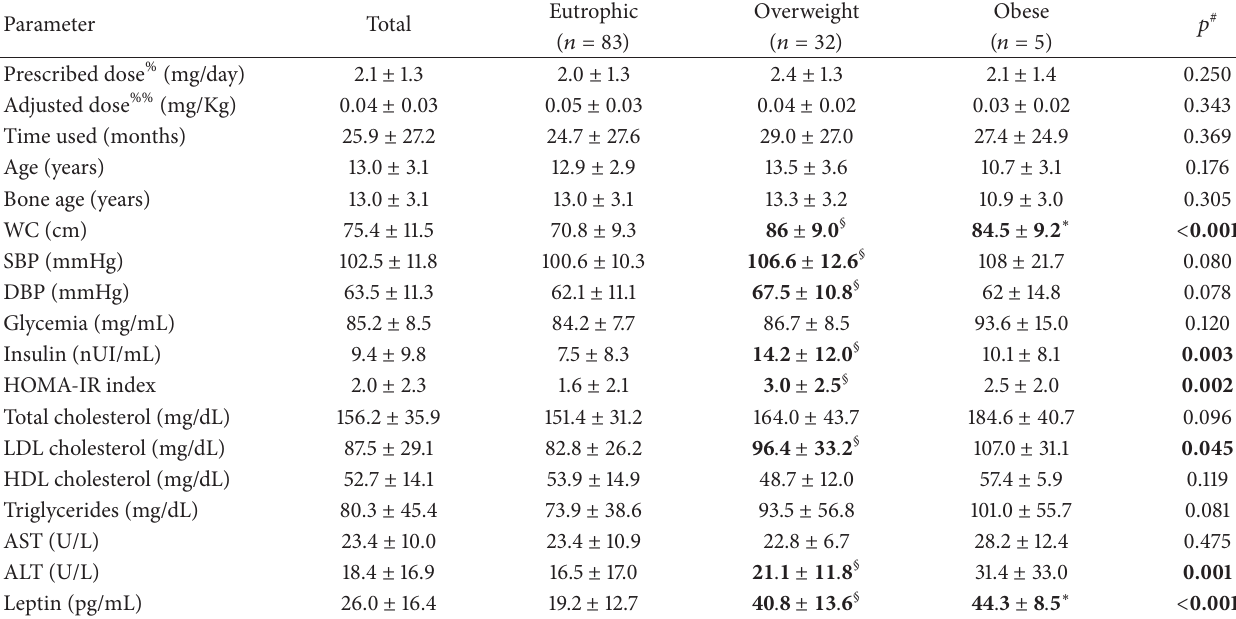
Table 2: Mean values and SD of clinical and laboratory parameters in relation to total assessments and nutritional status.